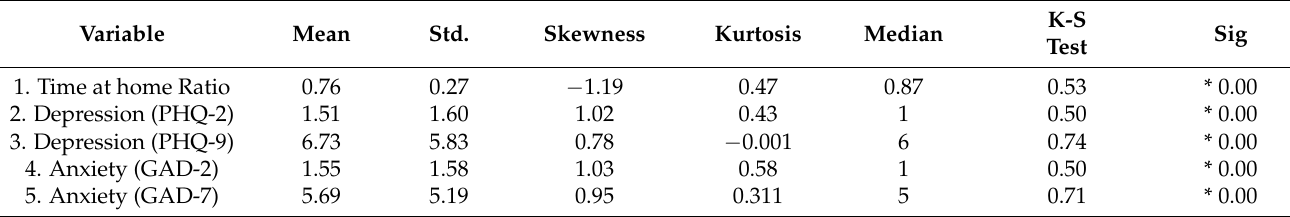
Table 2. Summary statement on the distribution of